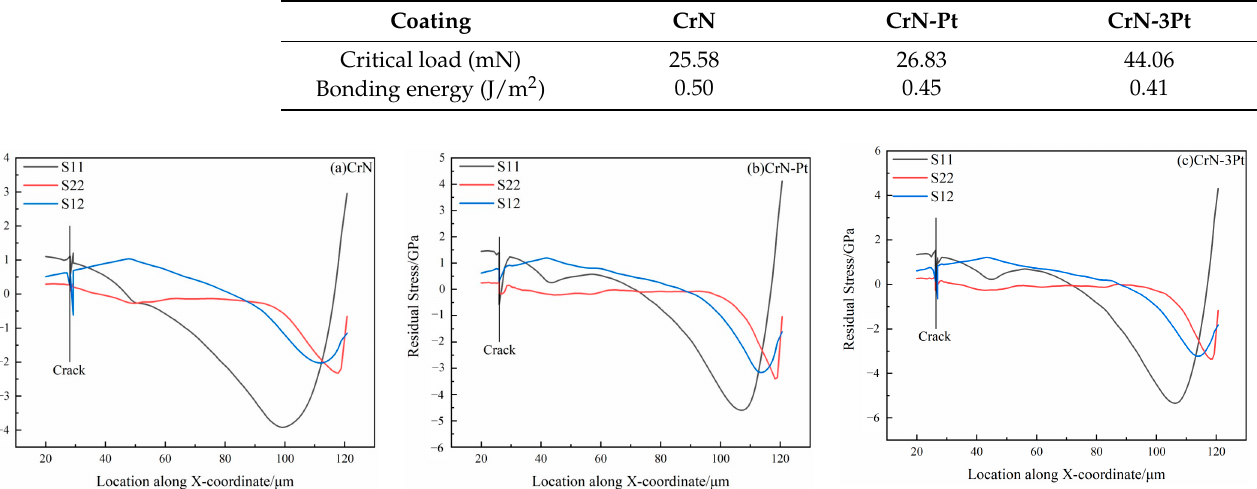
Table 4. Critical loads and film-substrate binding energies of the three coatings.